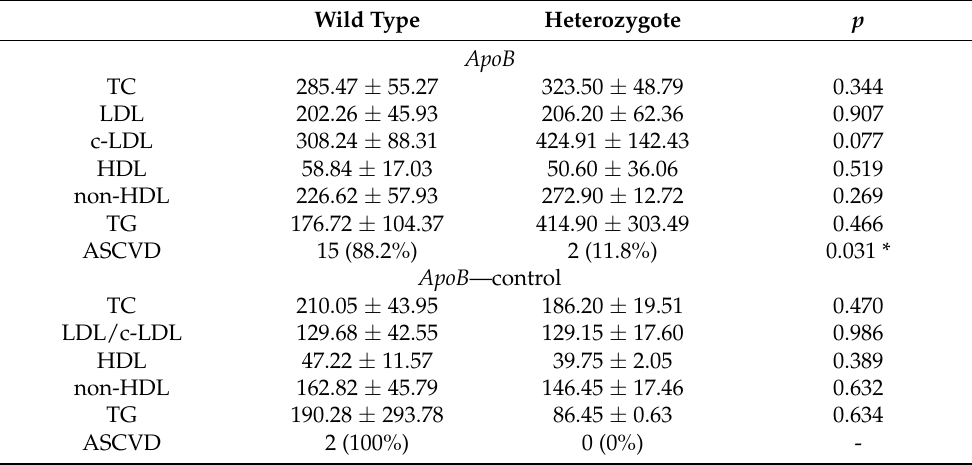
Table 4. Association between ApoB R3500Q polymorphism with ASCVD and lipid profile.